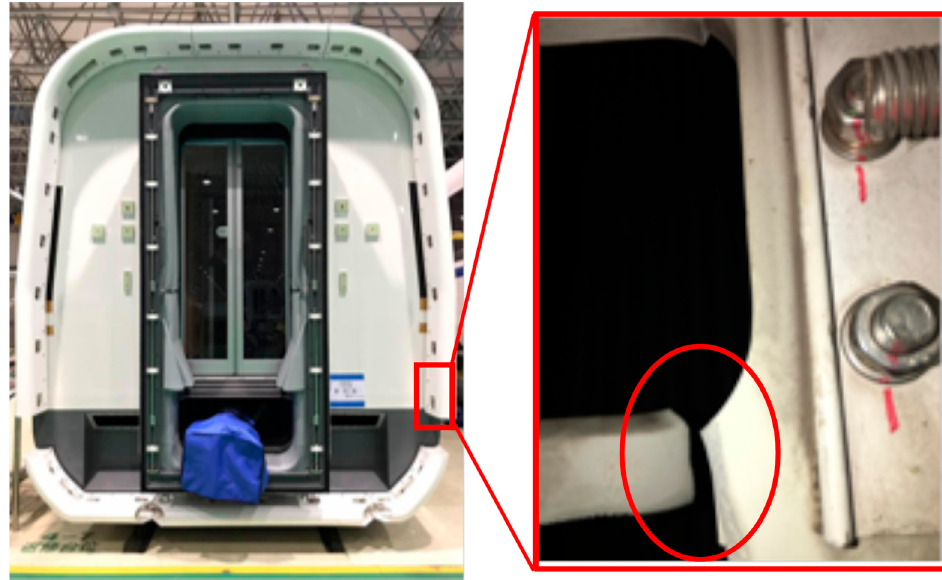
Figure 20. Fracture position in the rubber external windshield structure for Case 1.